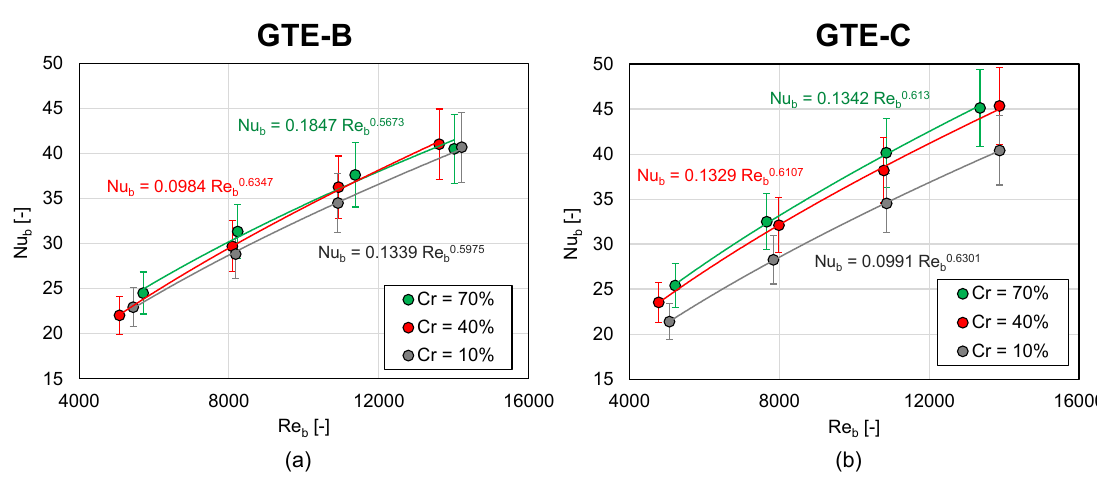
Figure 4. Nu b area averaged values for Ro b = 0 for ( a ) GTE-B and ( b ) GTE-C